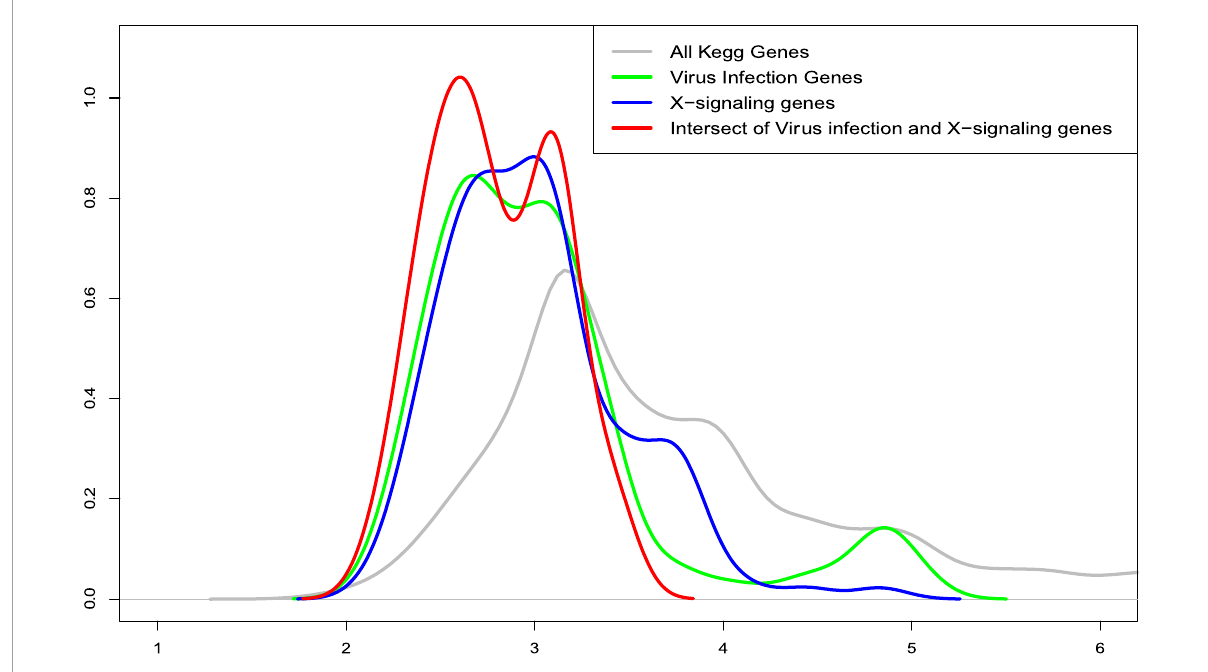
FIGURE6 The distribution of average shortest distance on the kyoto encyclopedia of genes and genomes (KEGG) signaling network between the upregulated genes in the inflammation related signaling pathways, including virus infection, immune response, and x-core signaling pathways to the apoptosis signaling genes. As seen, the inflammation signaling genes are much closer (see green, blue, and red) to the apoptosis genes compared with all other signaling genes (see gray lines). X -axis represents the shortest path distance; and y -axis is the density function.